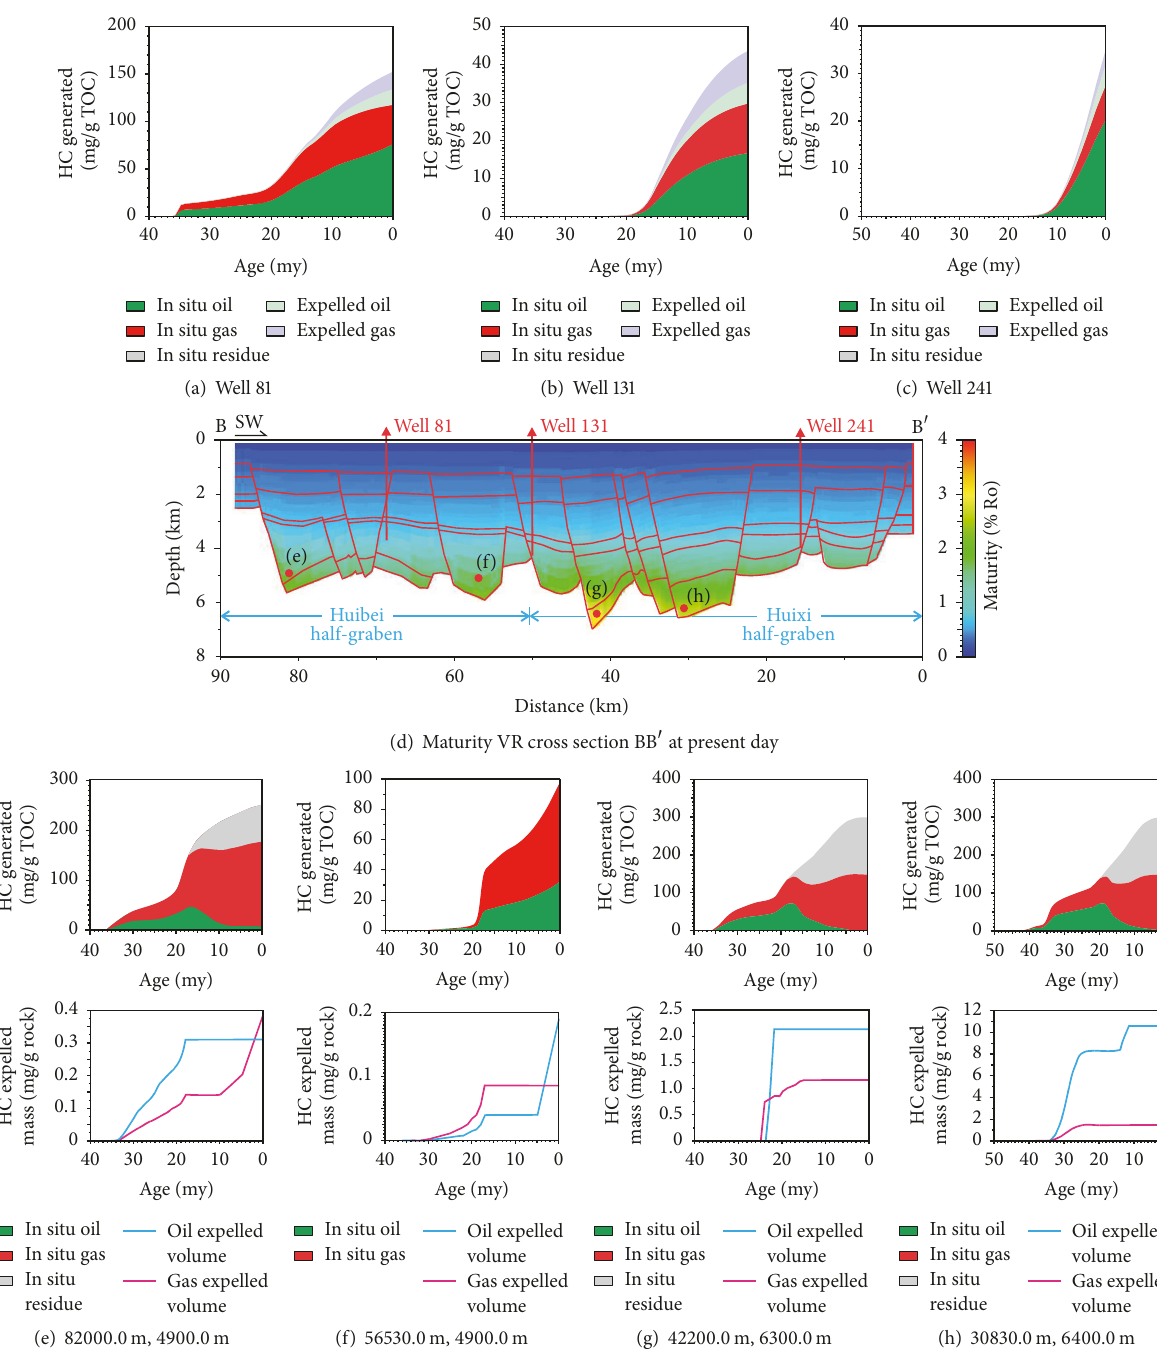
Figure 20: Hydrocarbon generation and expulsion of the Eocene source rocks in the Huizhou Sag (the locations of three wells and profile BB 󸀠 are shown in Figure